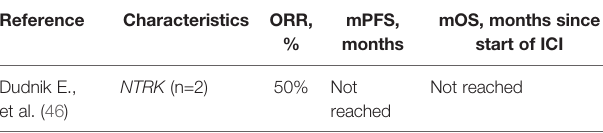
TABLE 6 | Ef fi cacy of ICIs in NSCLS with NTRK mutations.